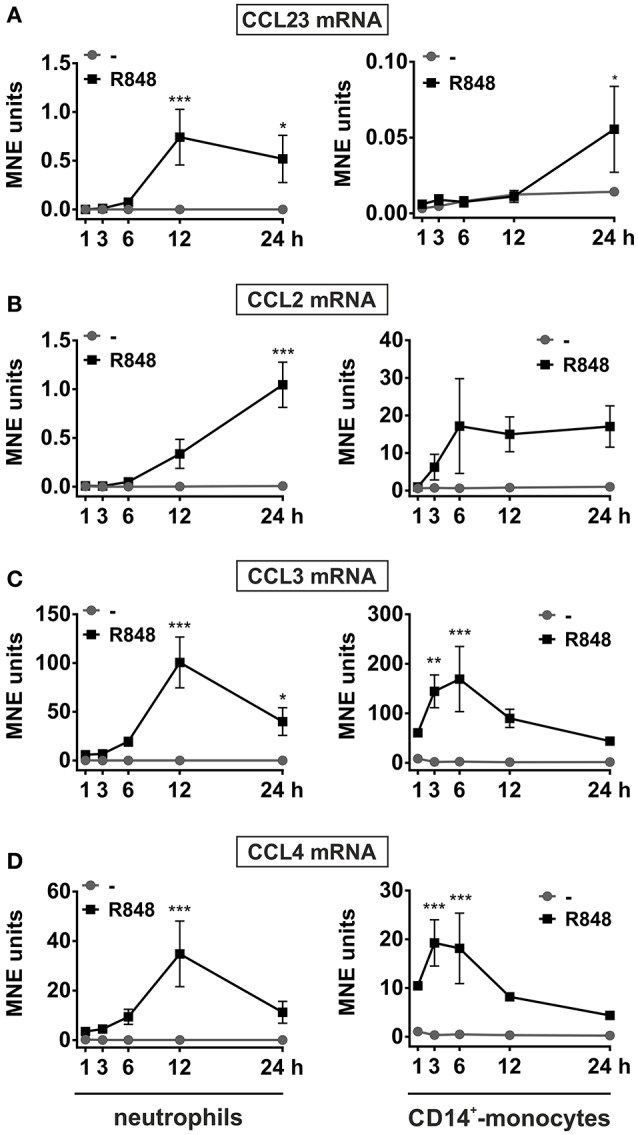
Kinetics of CCL23, CCL2, CCL3, and CCL4 mRNA expression in neutrophils and autologousCD14+-monocytes incubated with R848. Neutrophils and autologous CD14+-monocytes were cultured with or without 5 μM R848 for up to 24 h to evaluate their CCL23 (A), CCL2 (B), CCL3 (C), and CCL4 (D) mRNA expression by RT-qPCR. Gene expression is depicted as mean normalized expression (MNE) units after GAPDH mRNA normalization (mean ± SEM, n = 5). Asterisks stand for significant increase: *P < 0.05, **P < 0.01, ***P < 0.001, by two-way ANOVA followed by Bonferroni's post-test.